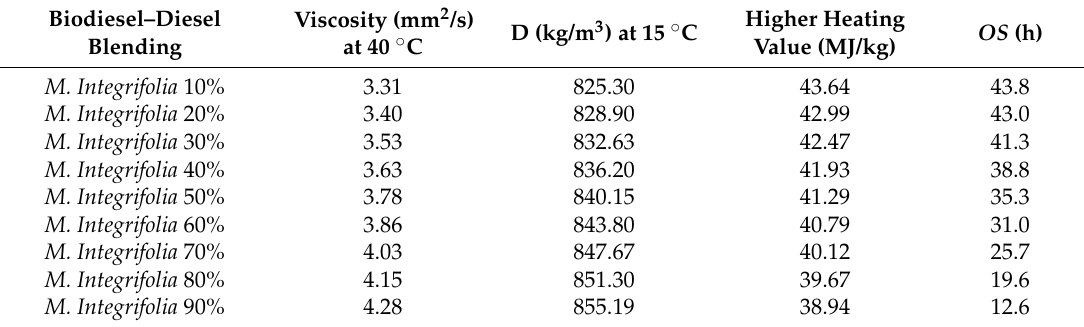
Table 6. Properties of macadamia biodiesel–diesel blends. M. Integrifolia : Macadamia Integrifolia . Biodiesel–Diesel